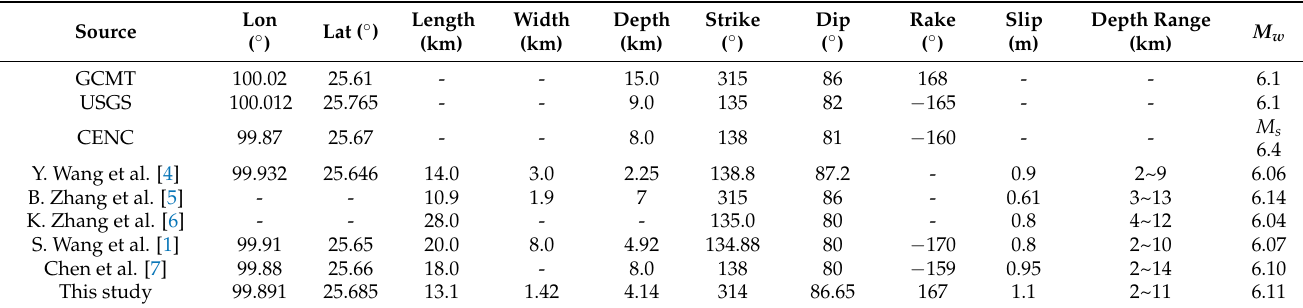
Table 1. Focal mechanism solutions of the 2021 M w 6.1 Yangbi